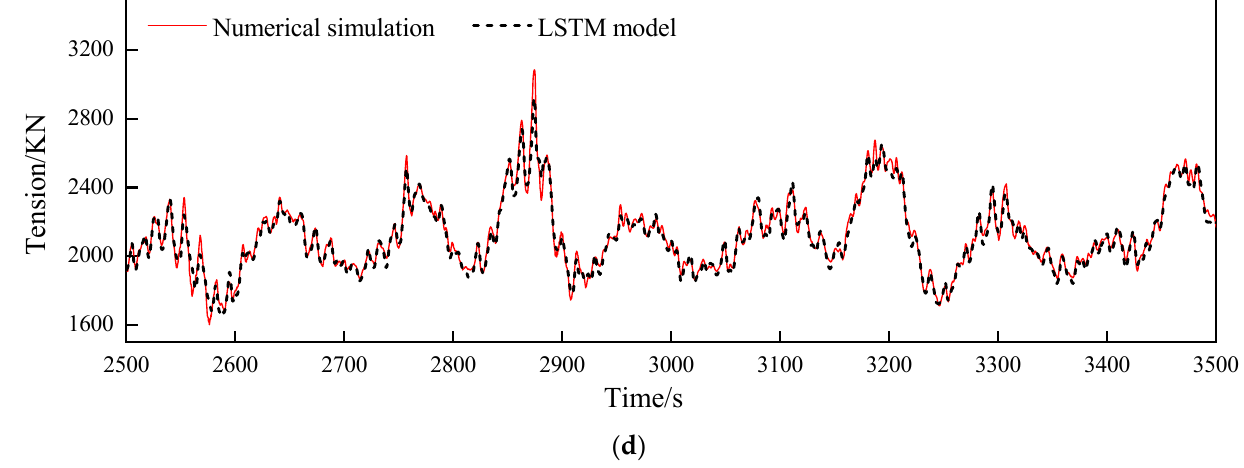
Figure 9. Comparison of prediction results under sea state 4–7 (line #1). ( a ) Tension time series prediction of line #1 under sea state 4; ( b ) tension time series prediction of line #1 under sea state 5; ( c ) tension time series prediction of line #1 under sea state 6; and ( d ) tension time series prediction of line #1 under sea state 7.